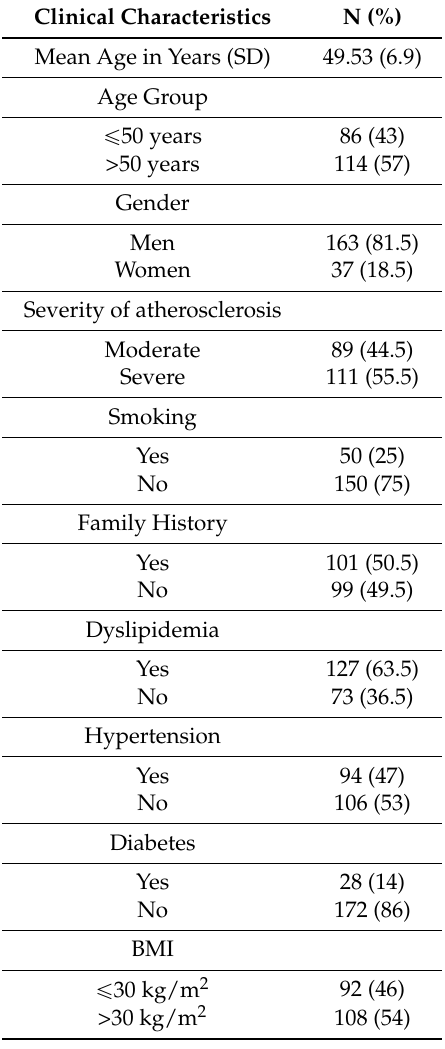
Table 1. Clinical characteristics of all 200 patients (Patients in Groups A and